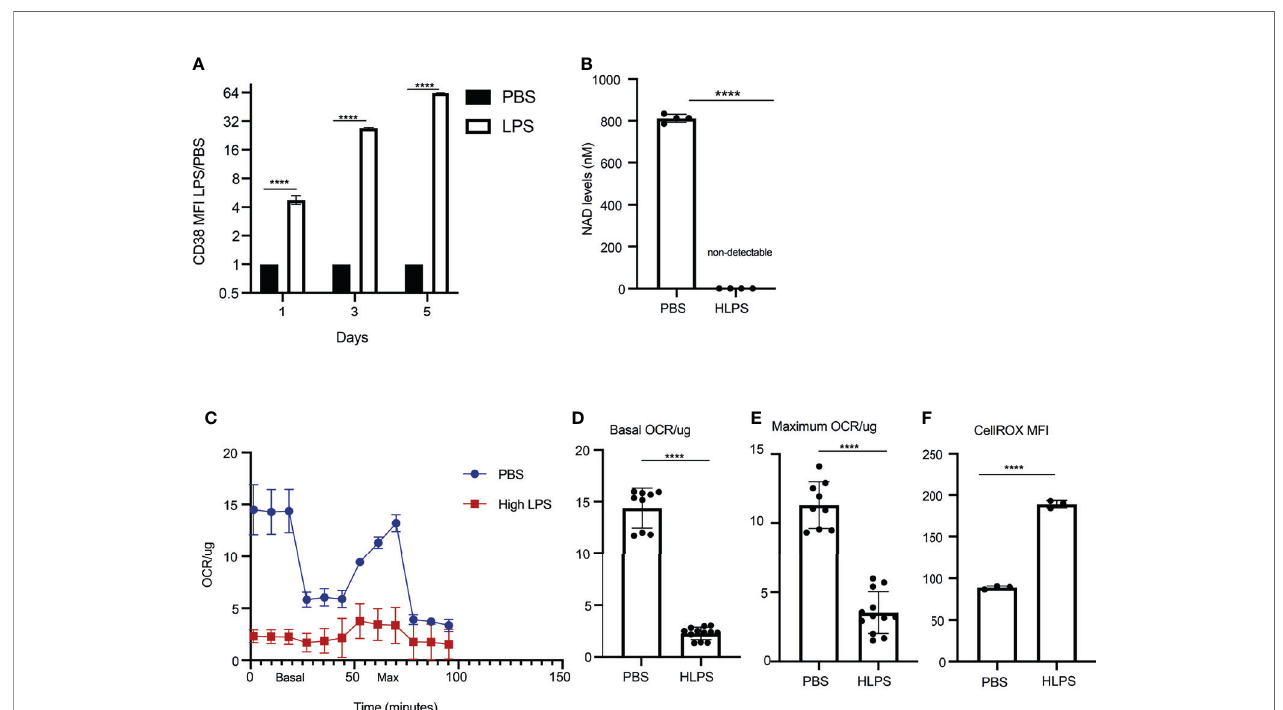
FIGURE 3 | Exhausted monocytes express elevated levels of CD38 and exhibit compromised mitochondria respiration. BMDMs were stimulated with PBS or high dose LPS (100 ng/mL) for 5 days. (A) CD38 MFIs on Day 1,3 and 5 were analyzed with fl ow cytometry. The relative fold changes in MFIs of CD38 comparing LPS- treated vs PBS-treated monocytes were determined and plotted in the graphs. n=3. (B) NAD + levels in monocytes treated with either PBS or high dose LPS were measured on Day 5 using a fl uorescence-based assay. n=4. (C) OCR/ug was determined by Seahorse assay. n=3. (D, E) The basal and maximum OCR/ug levels were quanti fi ed. n ≥ 9. (F) Intracellular ROS levels (n=3) were determined using fl ow cytometry. The data are representative of at least three independent experiments, and error bars represent means ± SEM. ****p < 0.0001, Student ’ s t